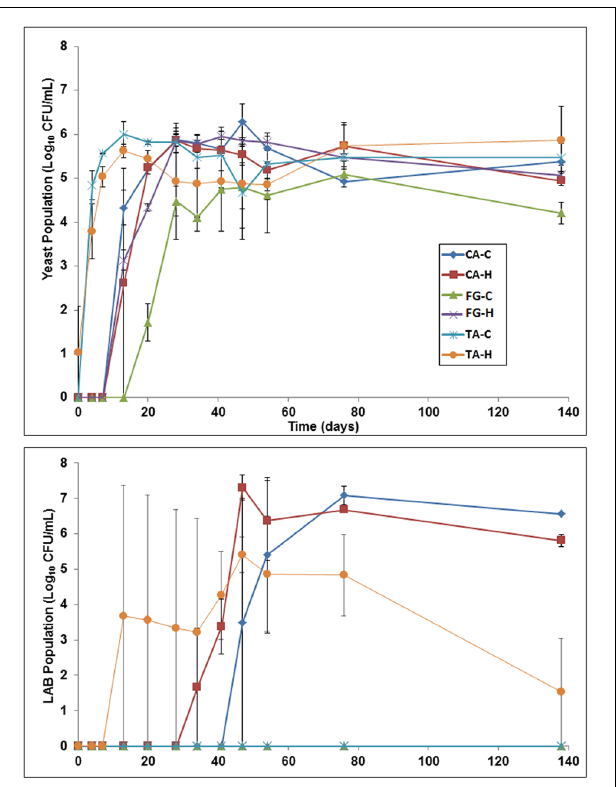
FIGURE 3 | Evolution of the yeast (upper) and lactic acid bacteria (lower) populations during fermentation in the diverse treatments. Error bars denote standard deviation calculated from duplicate fermentation vessels. CA-C, cured control; CA-H, heat-shocked cured olives; FG-C, refrigerated fresh green control; FG-H, heat-shocked refrigerated fresh green olives; TA-C, control of traditional olives; and TA-H, heat-shocked traditional olives. All treatments were applied to the Aloreña de Malaga